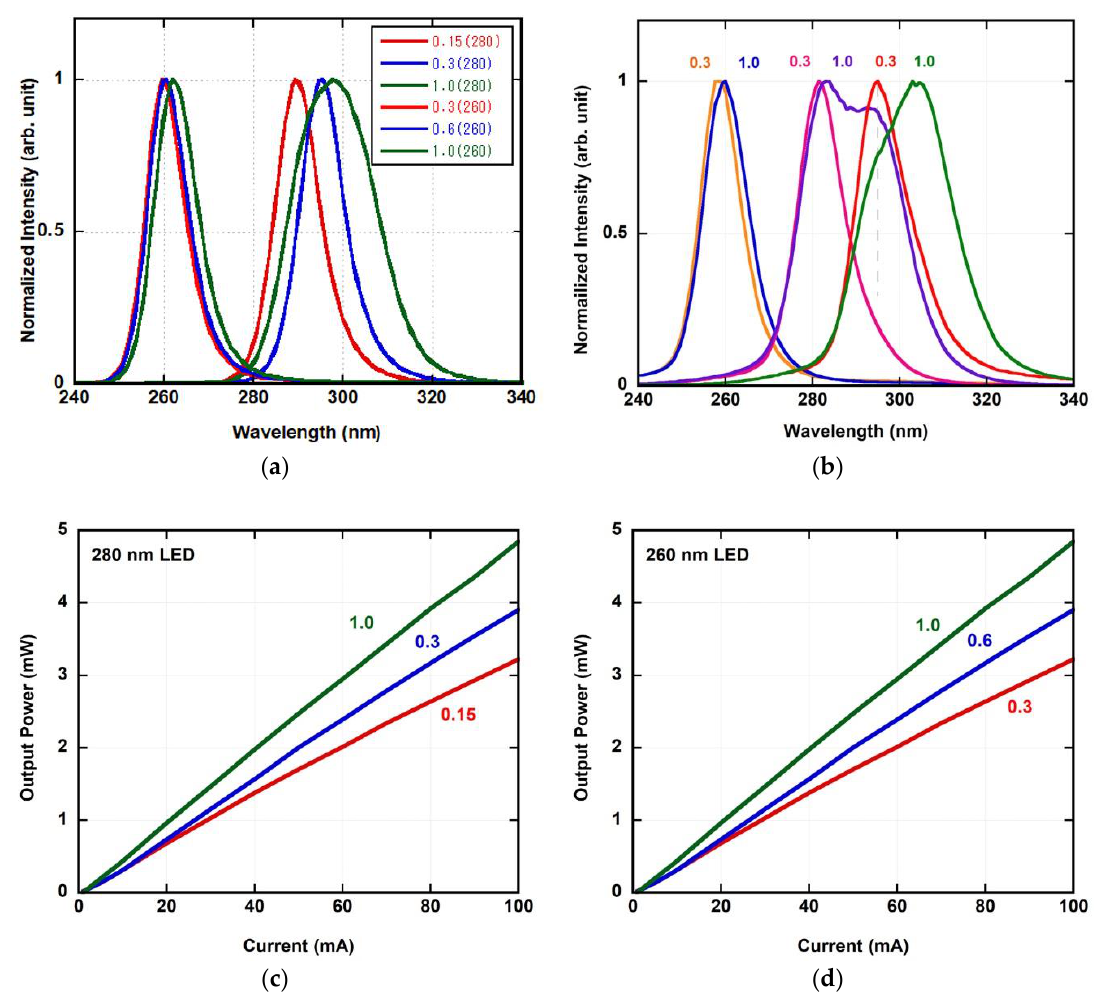
Figure 15. ( a , b ) Redshift of EL spectra observed in case of using high-miscut sapphire. The spectra in ( a ) were controlled to have single peaks. ( c , d ) I-L characteristics of 260 and 280 nm LEDs for different miscut angles of sapphire, respectively. Graph ( b ) includes spectra with a shoulder to show the possible existence of quasi-stable AlN in AlGaN. The indices above the spectra or I-L characteristics in ( b , d ) denote the miscut angles of sapphire. Both ( c , d ) show that the EL output increases with increasing miscut angle of sapphire for the samples in ( a ). (( b ) is permiited to reuse from [13] and ( a , c , d ) are permitted to reuse from Proc. SPIE 9926, 99260C (2016)